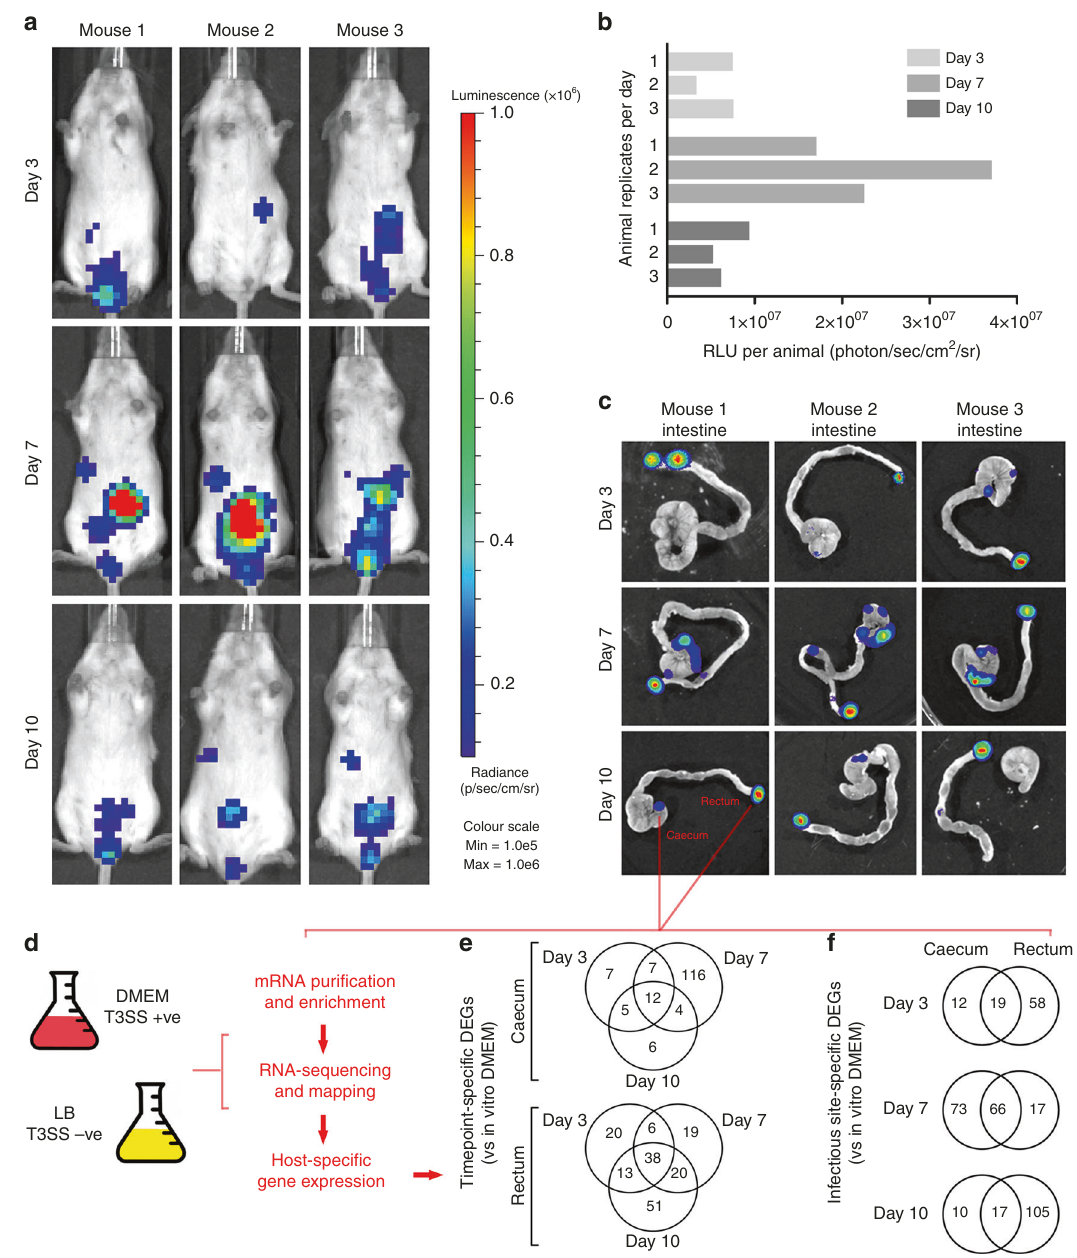
Fig. 1 In vivo RNA-seq analysis of C. rodentium gene expression during murine infection. a Monitoring of murine colonization by lux -marked C. rodentium using IVIS. The scale of luminescence radiance (p/s/cm/sr) is normalized to a maximum of 1 × 10 6 . b Quanti fi cation of IVIS data for each animal infected as per panel a . c IVIS analysis of dissected intestines corresponding to animals from panel a , which were used to process localized bacterial mRNA from the caecum and rectum sites (highlighted in red). d Experimental work fl ow for in vivo RNA-seq analysis. Control conditions (DMEM/T3SS + ve and LB/T3SS – ve) were used as a comparator to infection derived transcripts obtained for C. rodentium . e Venn diagrams depicting the number of differentially expressed genes (DEGs; >1.5-fold change in expression versus growth in DMEM; P ≤ 0.05 EDGE test) identi fi ed over the course of infection according to site of colonization. f Venn diagrams depicting the number of DEGs identi fi ed between sites at each time